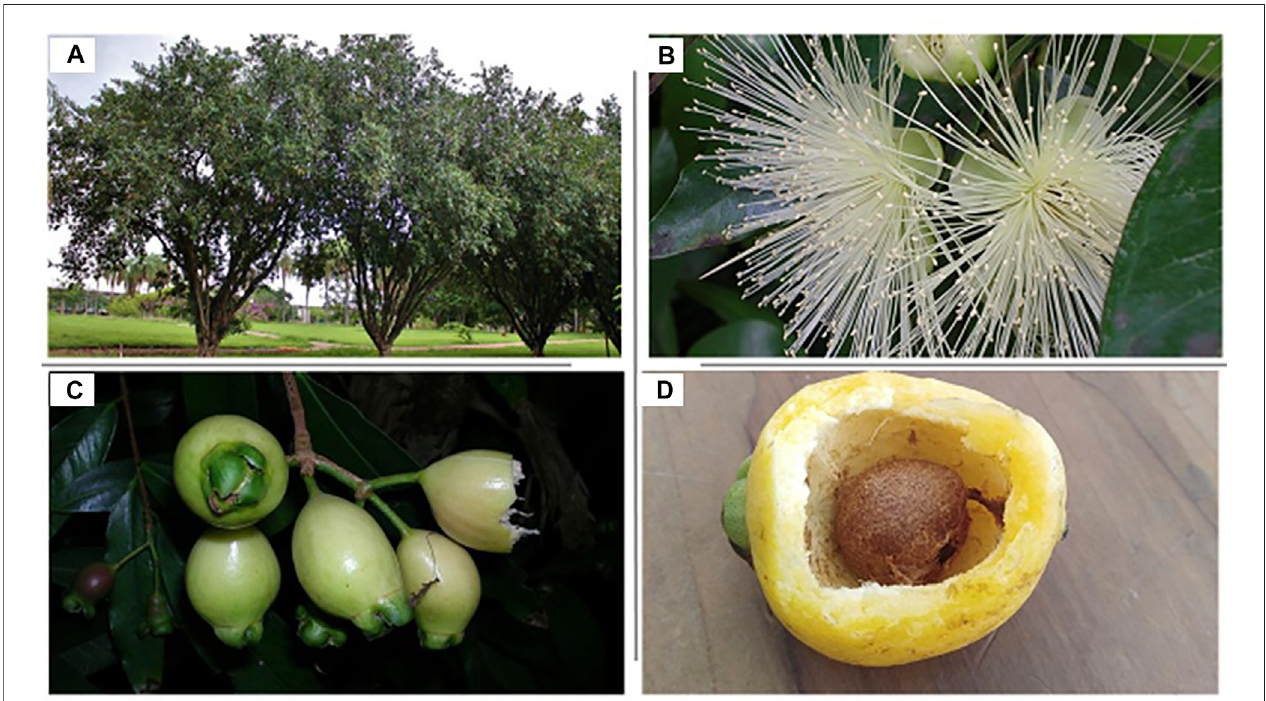
FIGURE 1 | Syzygium jambos (A) tree, (B) fl owers, (C) unripe fruits and (D) seeds.